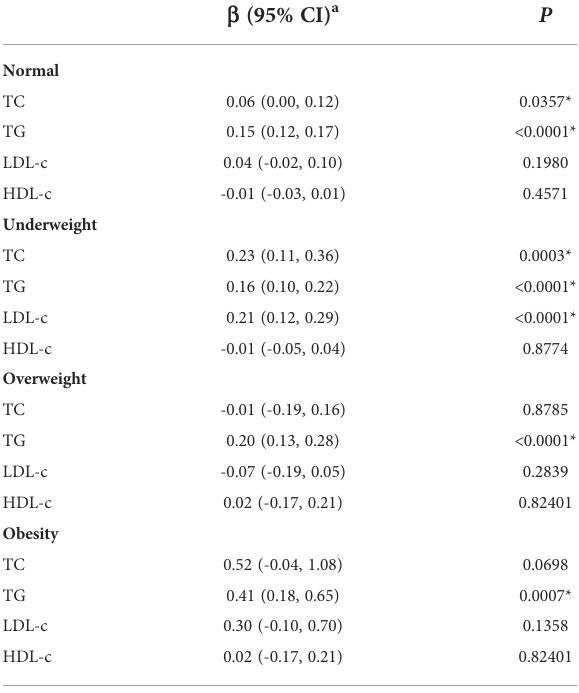
TABLE 3 The association between blood metabolic markers in early pregnancy and fetal birth weight by different BMI groups. b (95% CI)